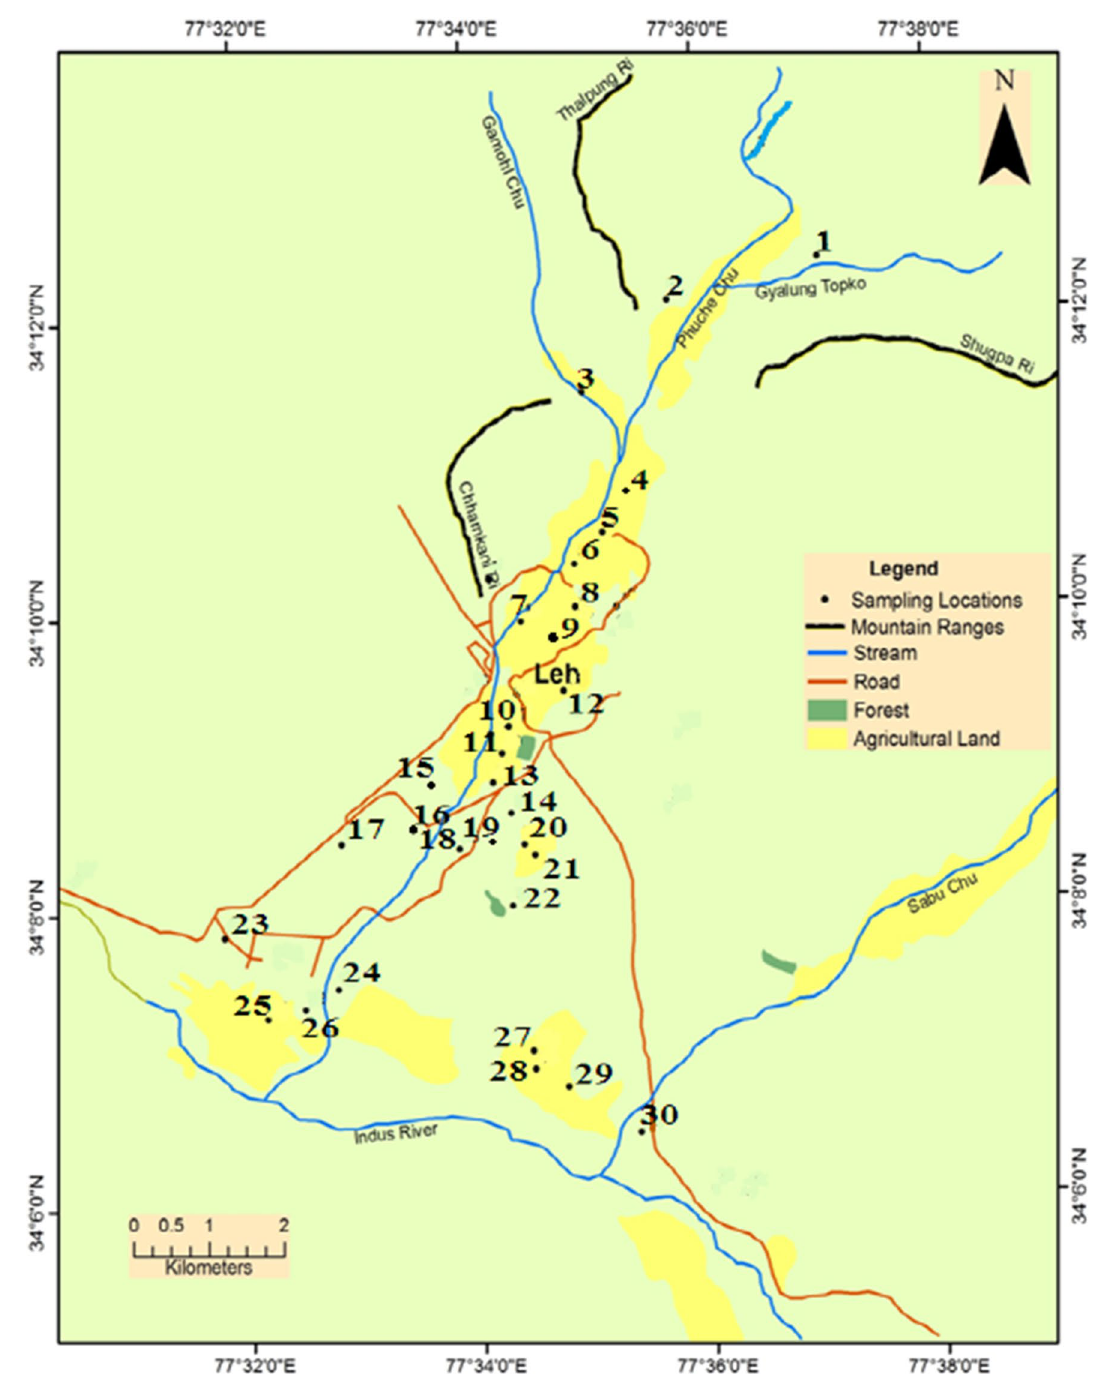
Fig. 2 Location map of groundwater sampling